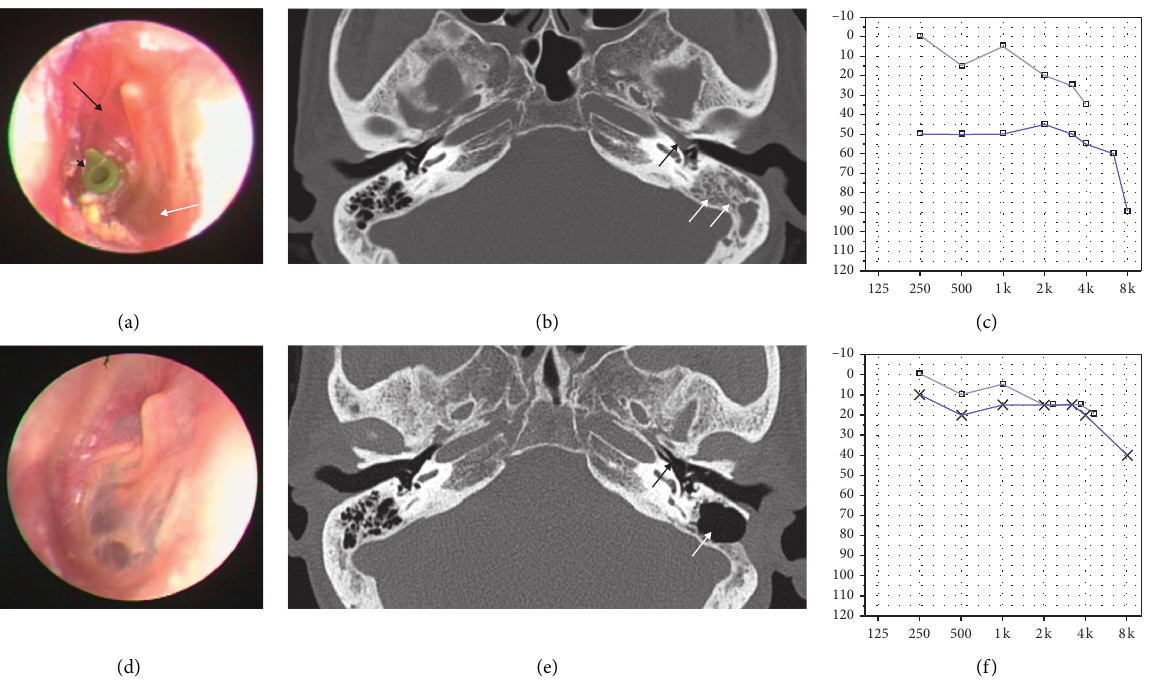
Figure 1: Preoperative (a–c) and postoperative (d–f) clinical findings. (a) Preoperative otoendoscopic examination revealed a pinkish mass- like lesion (black arrow) behind the anterior portion of the tympanic membrane. Middle ear effusion is observed (white arrow) despite previous ventilation tube insertion (black arrow head). (b) Axial view of temporal bone computed tomography (TBCT) demonstrated soft tissue density obstructing the bony portion of the Eustachian tube (black arrow) and mastoiditis (white arrows). (c) Pure tone audiometry showed conductive hearing loss with an air-bone gap of 37 dB in the left side. (d) Postoperative otoendoscopic examination revealed normal tympanic membrane. (e) Axial view of TBCTdemonstrated a clean mastoid cavity (white arrow) and no residual mass in the bony portion of the Eustachian tube (black arrow). (f) Pure tone audiometry showed that the air-bone gap was reduced to 5dB in the left side.